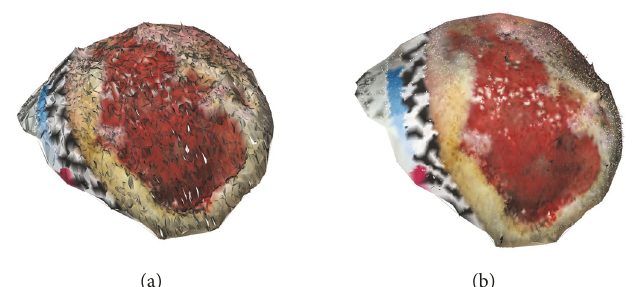
Figure 5: (a) The result of Delaunay triangulation algorithm which is a rough surface including some holes. (b) The smooth and integrated surface after filtering.